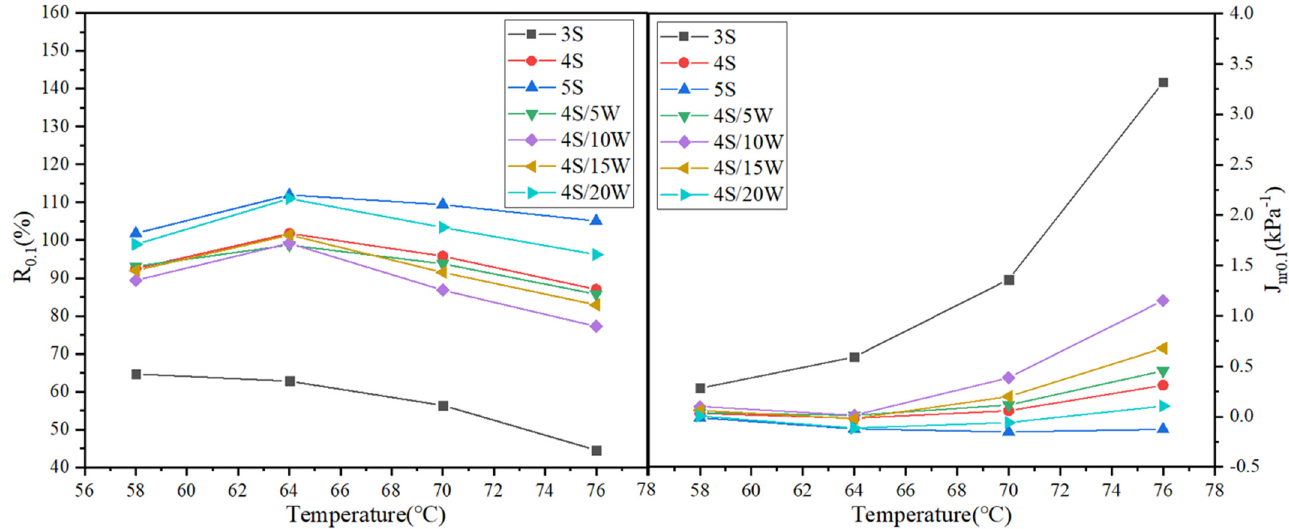
Figure 7. R 0.1 and J nr 0.1 of WPU/SBS composite modified asphalt.